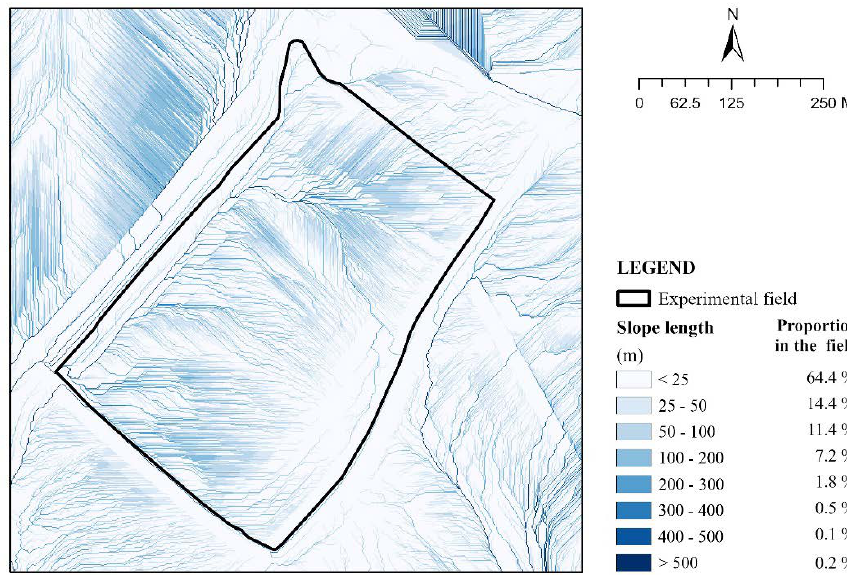
Figure 4. Slope length of the experimental field (determined from the raw data [33]).